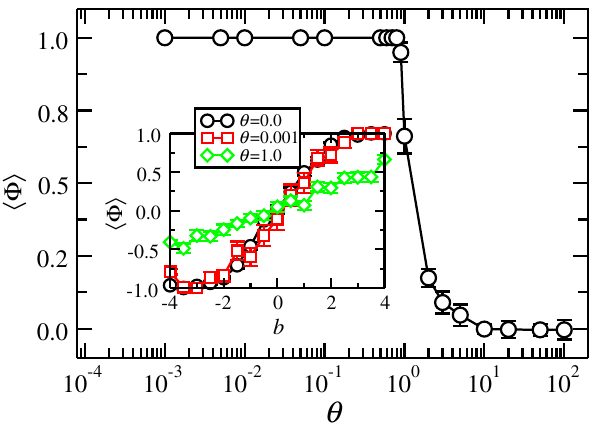
FIG. 5. Average order parameter as a function of θ , for ρ ¼ 0 . 6 , ¼ 6 , and H ¼ 2 . The inset shows the crossover from b ¼ 8 , v d h Φ i ¼ − 1 to h Φ i ¼ 1 as b changes from − 8 to 8, for different values of θ